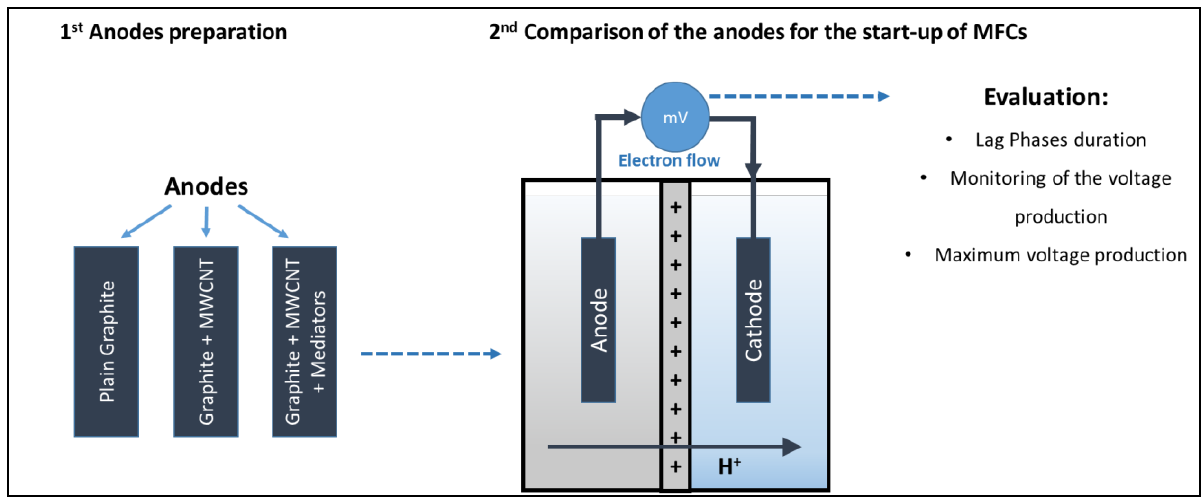
Figure 2. Schematic representation of the followed research